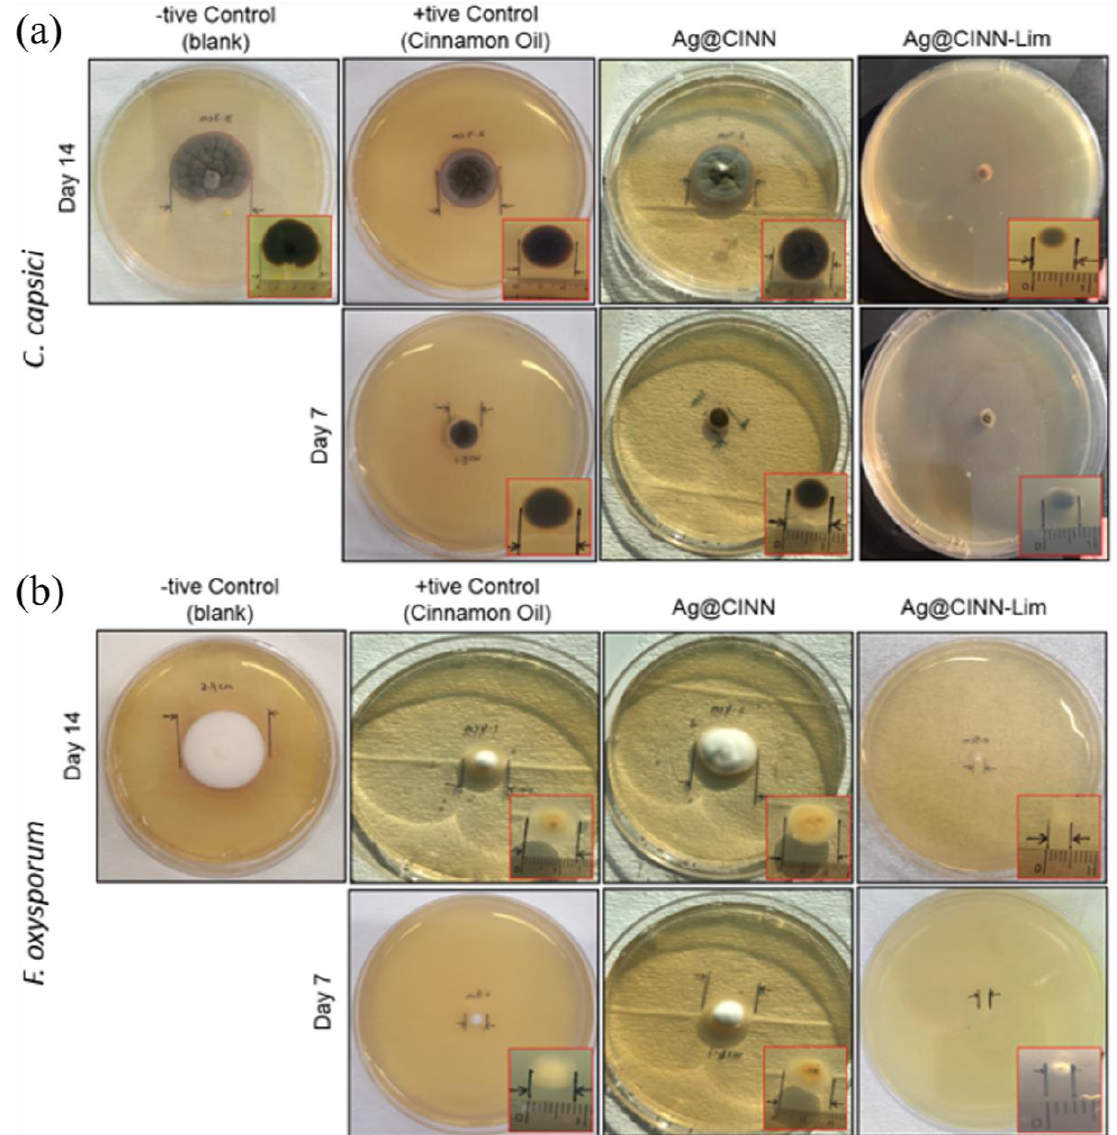
Figure 6. Photographic image of agar plate showing the growth of fungi: ( a ) C. Capsici ( b ) F. oxysporum .